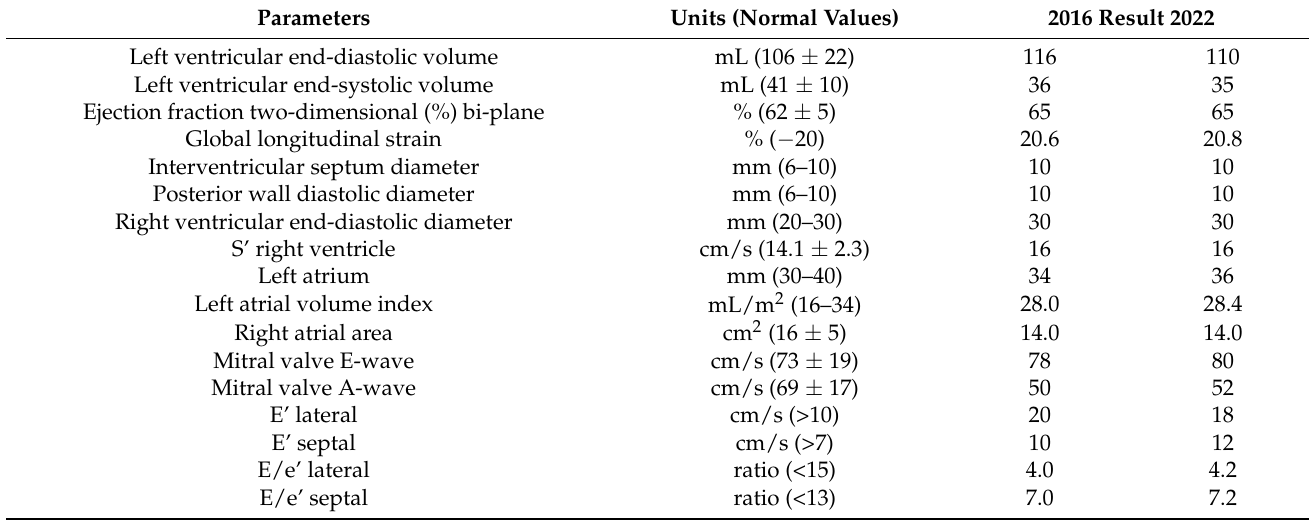
Table 3. Echocardiographic parameters of heart systolic and diastolic